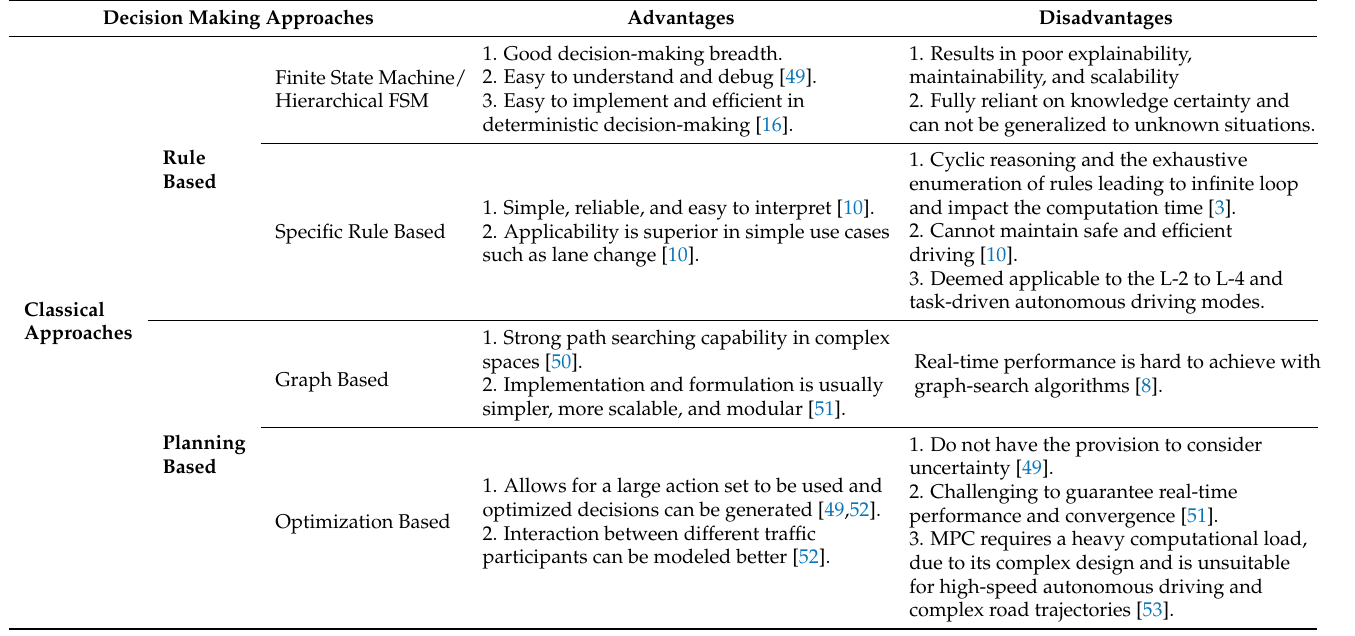
Table 2. Comparison of the Classical Solution Approaches for